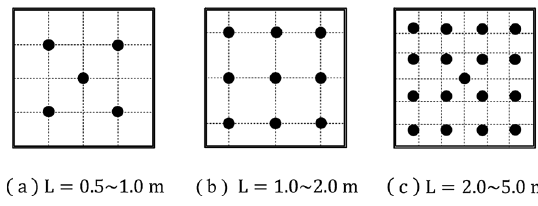
Fig. 8 Schematic diagram of the monitoring points in blocks of dif- ferent